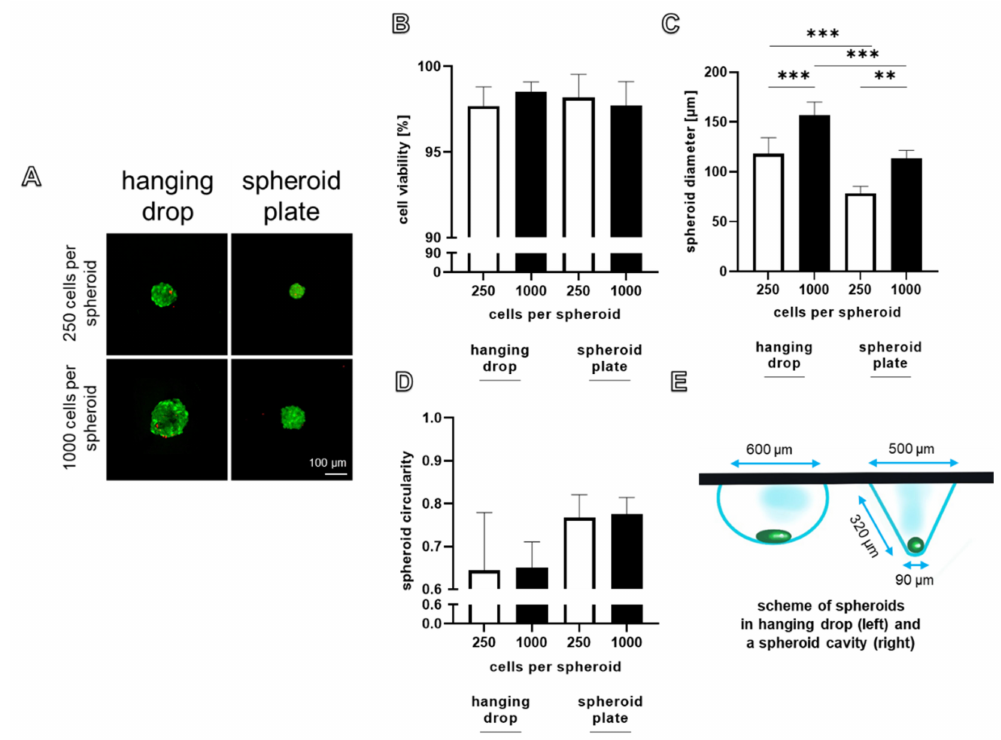
Figure 3. Direct comparison of viability and sizes of spheroids produced with the hanging drop and spheroid plate methods using either 250 or 1000 cells per spheroid at day 7. ( A ) Dead cells stained with propidium iodide are red and living cells metabolizing fluorescein diacetate are green. Viability was monitored by CLSM after 7 days. Scale bar: 100 µ m. ( B ) The number of dead and viable cells was calculated using ImageJ. ( C ) Spheroid diameters were measured using the CLSM. ( D ) Spheroid circularity was defined using ImageJ. ( E ) Schematic representation of spheroids in a hanging drop (50 µ L) and a spheroid cavity. Statistics: n = 3-5 independent experiments were performed with cells of three different donors. One-way ANOVA (Tukey’s multiple comparisons test) for comparison between groups. p values: ** < 0.01, *** < 0.001 ( B , C , D